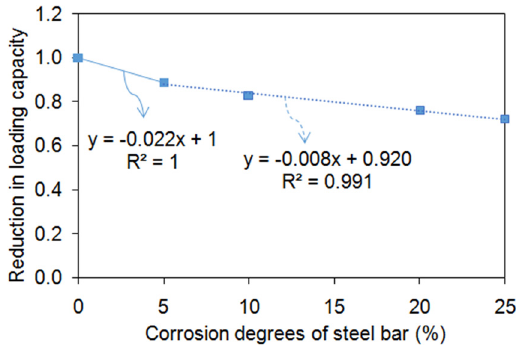
Figure 20: Reduction ratio of